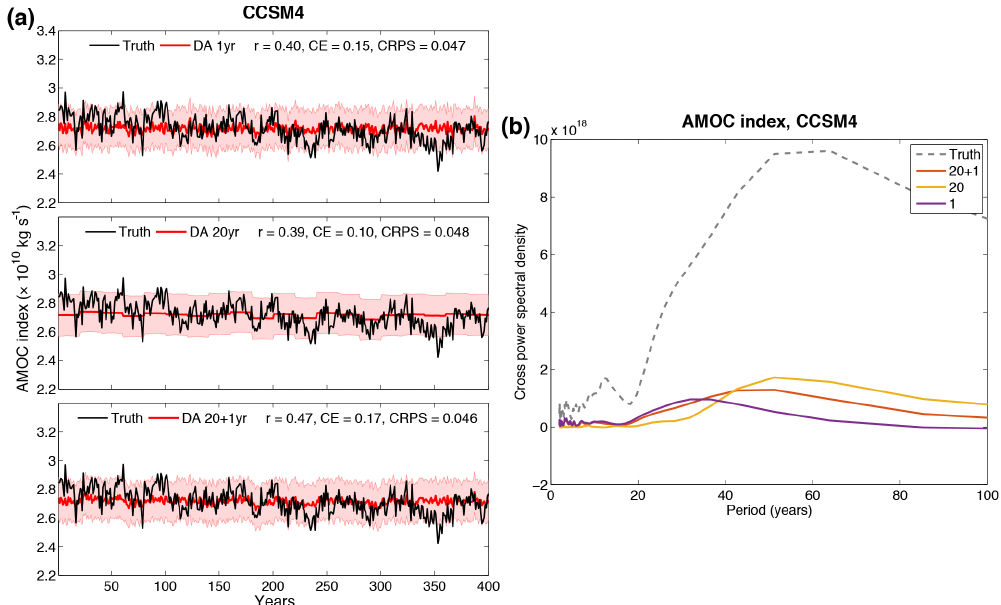
Figure 10. AMOC index reconstructions (mean of 100 Monte Carlo iterations, with error bars indicating ± 2 σ of the iterations and analysis ensembles) and corresponding cross spectra similar to those shown in Figs. 8b, d, f and 9b but for the case where each experiment uses 200 pseudoproxies: the single-timescale reconstructions use 200 pseudoproxies each, while the multi-timescale reconstructions use 100 pseudoproxies for the short timescale and 100 pseudoproxies for the long